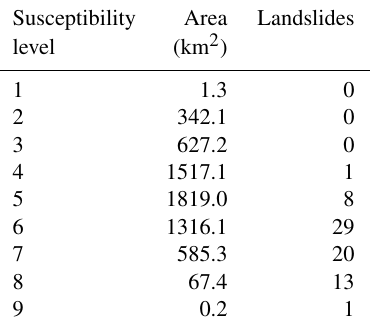
Table 8. Areas of susceptibility level of map and observed land-